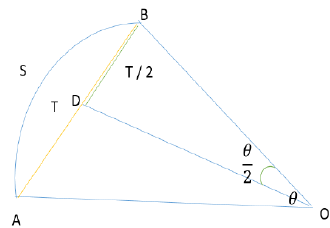
Figure 3. Notations (on the figure) depicting ego vehicle movement from point A to point B. The final expression of T can be identified by combining Equations (5)–(7).